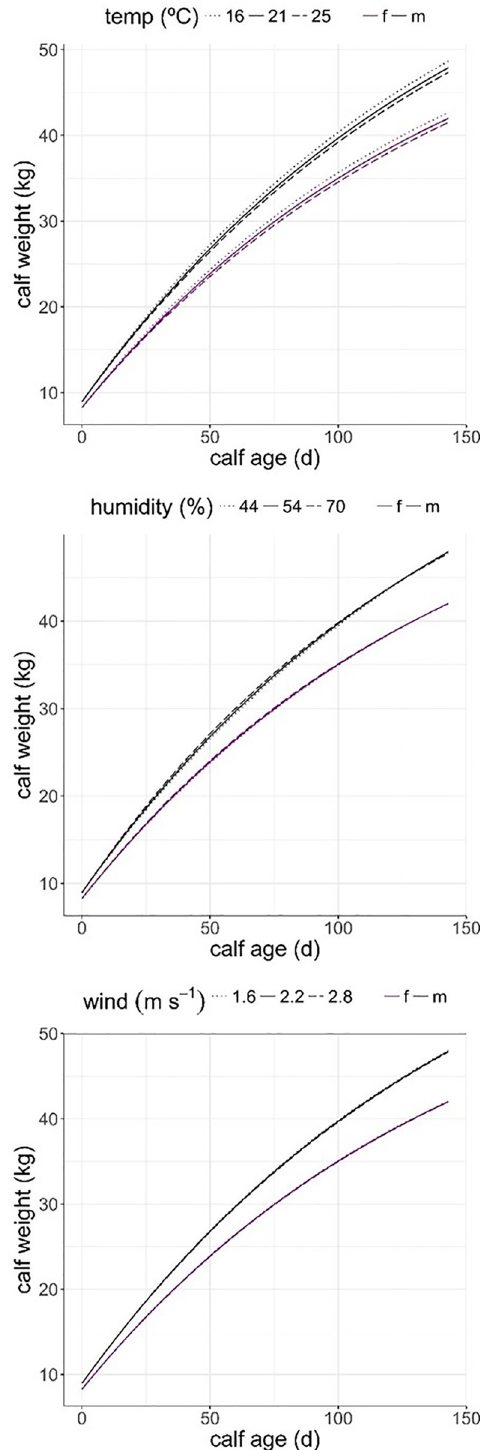
Fig 3. Predicted calf growth from birth to forced weaning (day 143) from model in Table 4, for three values of mean daily air temperature (16˚C, 21˚C, 25˚C) corresponding to quantiles 0.1, 0.5 and 0.9; air humidity (quantiles 0.1 = 44%; 0.5 = 54%; 0.9 = 70%) and wind speed (quantiles 0.1 = 1.6 m � s -1 ; 0.5 = 2.2 m � s -1 and 0.9 = 2.8 m � s -1 ); f: female calf (magenta); m: male calf (black).